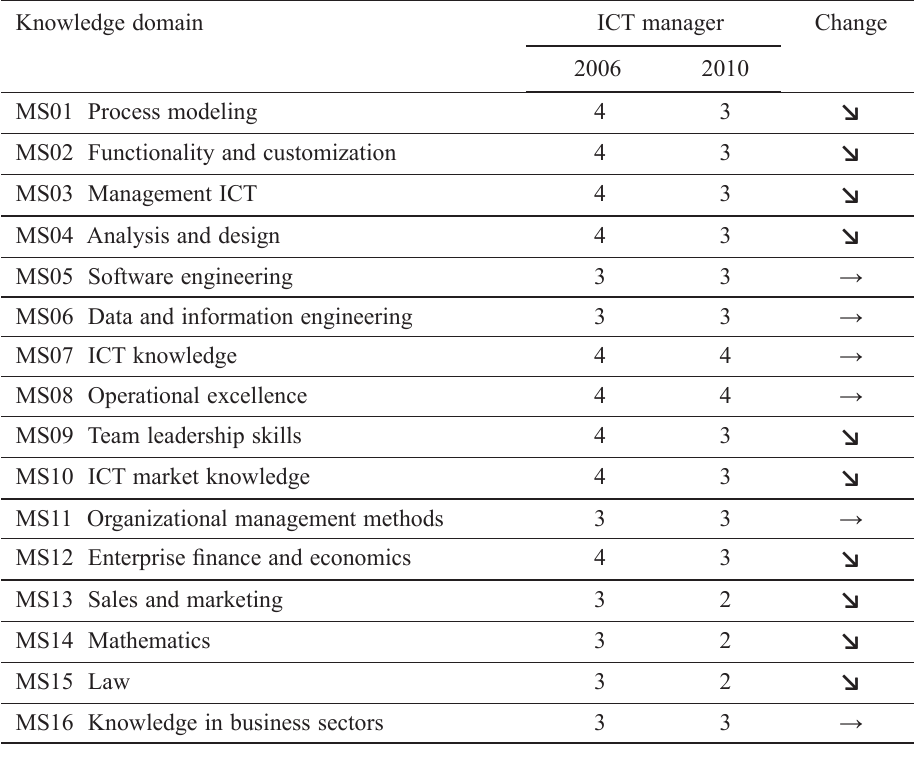
Table 6. Requirements of companies on role ICT manager